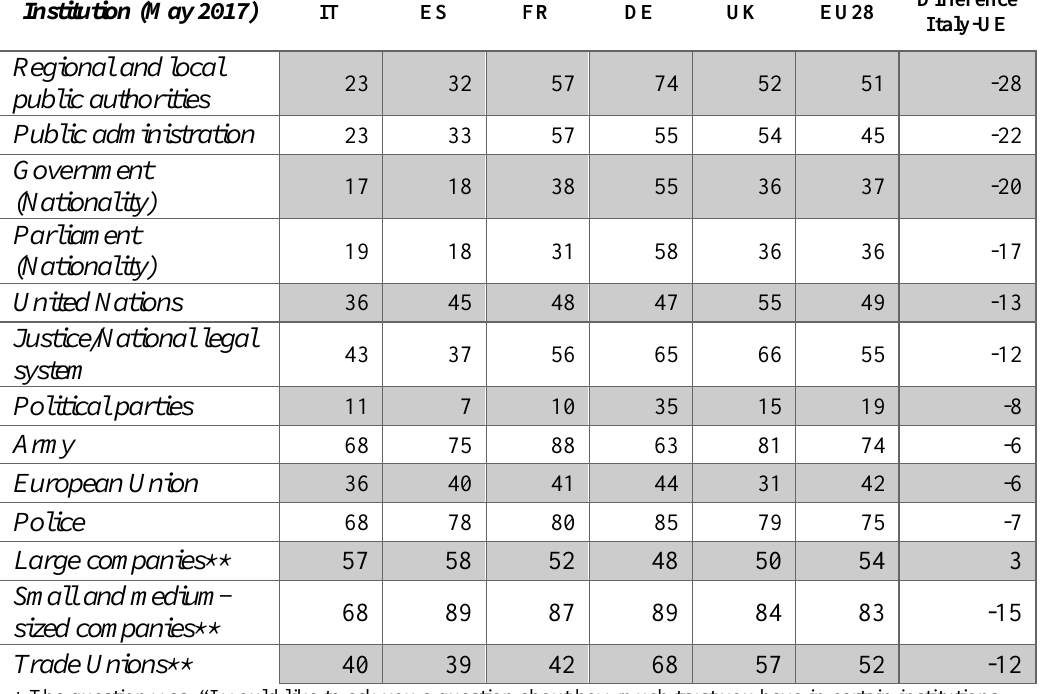
Table 1: Public Opinion in the European Union, May 2017* – Standard Eurobarometer 87